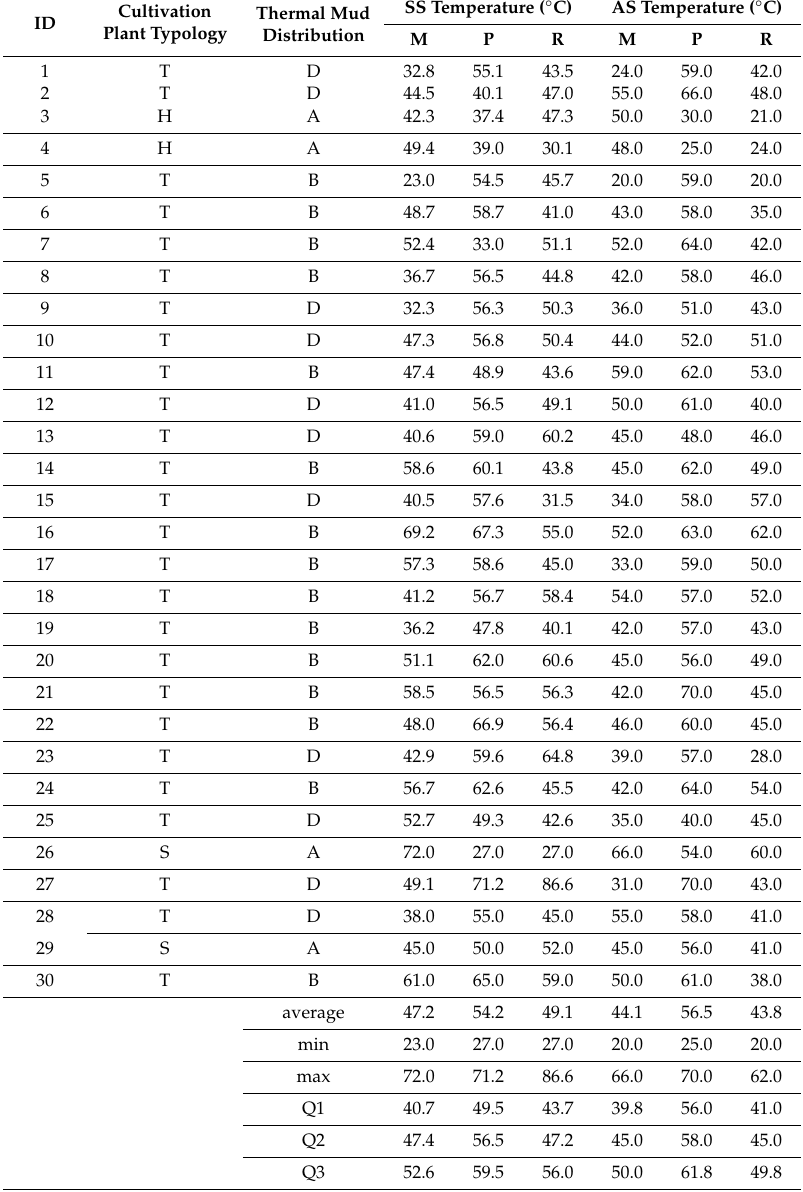
Table 2. Characteristics of surveyed facilities and temperature of sampling sites. The table reports the mud cultivation technique (T—traditional tanks, S—mechanized silos, H—hybrid system); thermal mud (TM) distribution method (D—direct collection from tank, B—bagnomaria bucket, A—automated dispenser). Temperatures recorded in each sampling point (M—maturing mud tank, P—peloid, R—regenerating used mud) are also reported for the spring (SS) and autumn sampling (AS). Average temperature for each mud type, minimum and maximum values and first (Q1), second (Q2) and third quartile (Q3) are also reported. Cultivation Thermal Mud ID Plant Typology